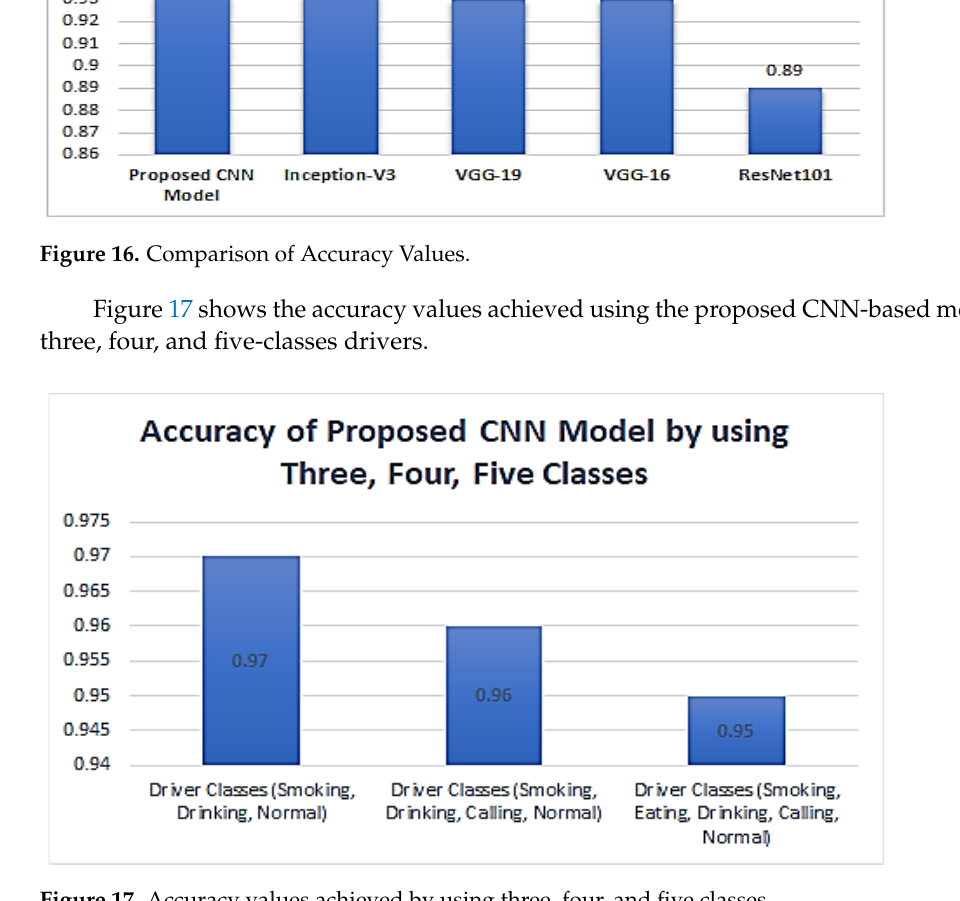
Figure 17. Accuracy values achieved by using three, four, and five classes.